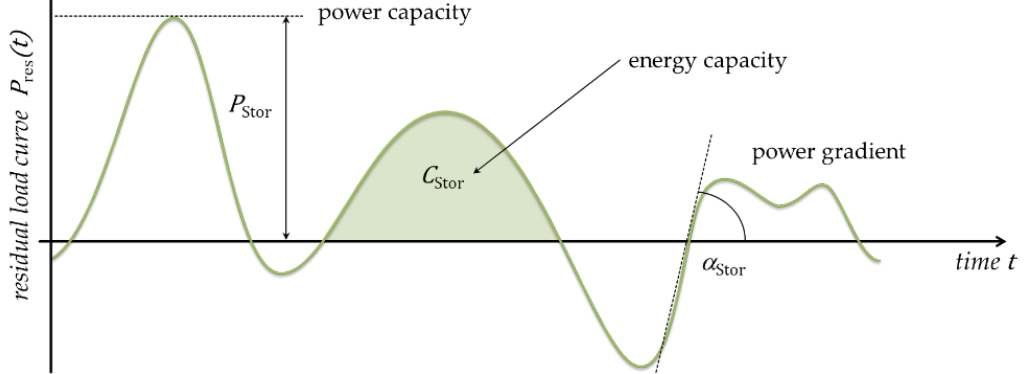
Figure 1. Storage parameters from battery load curve.